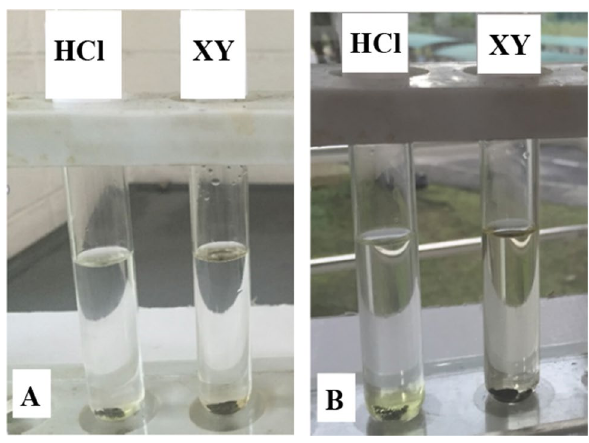
Fig. 2 Mixed scale deposit Sample 1 in different solutions of hydro- chloric acid (50% concentrated) and xylene. a Picture captured imme- diately after the deposit and solution come in contact. b Picture cap-